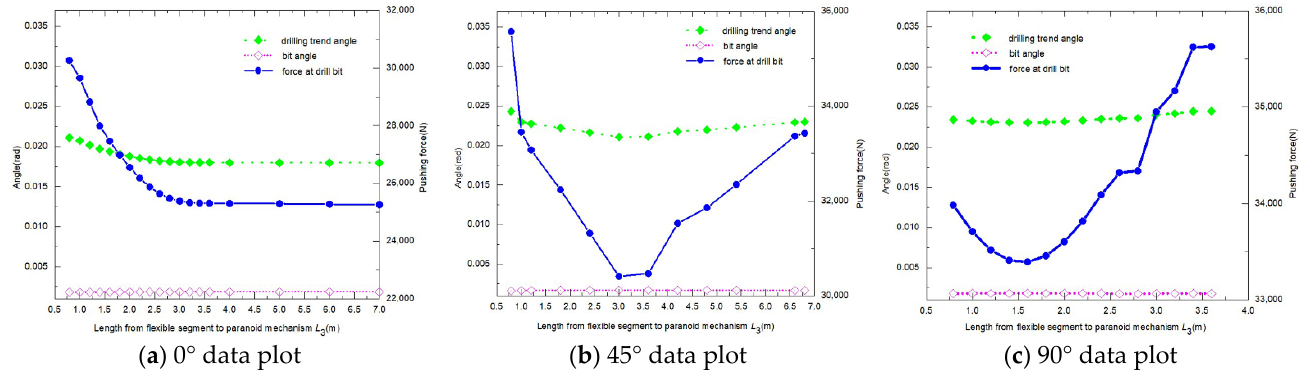
Figure 8. Influence of the length from the flexible segment to the paranoid mechanism (L3) on trajectory control capacity.